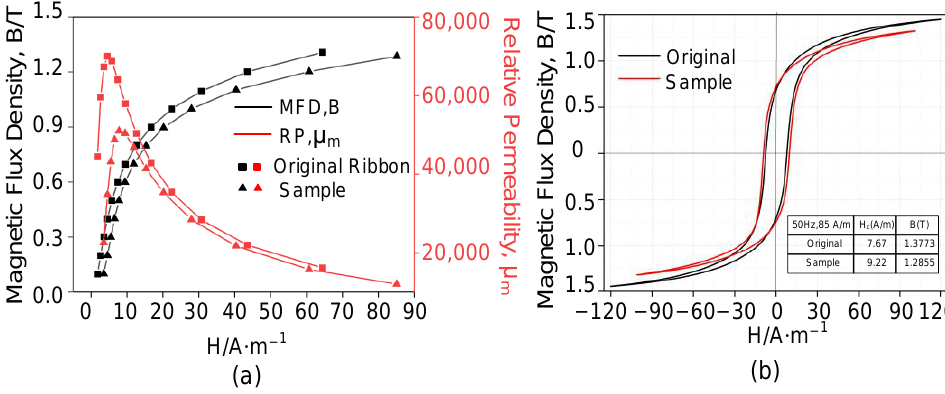
Figure 5. Magnetic test results of the original ribbon and processed sample. ( a ) Magnetization curve and magnetic permeability curve. ( b ) The magnetic hysteresis loops at 50Hz.